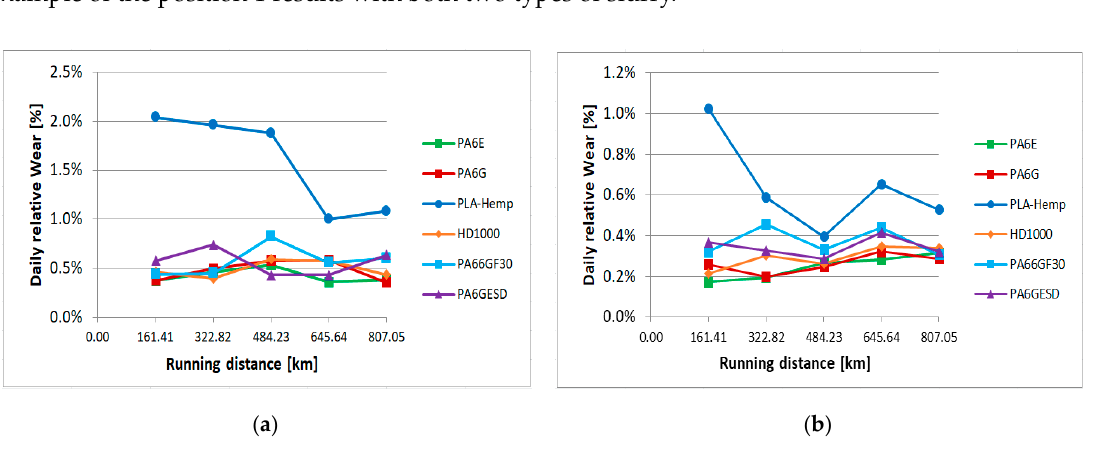
Figure 12. The relative wear of the tested materials in loamy soil-based slurry ( a ) position 1, ( b ) position 2, ( c ) position 3, ( d ) position 4 (Figure 3).